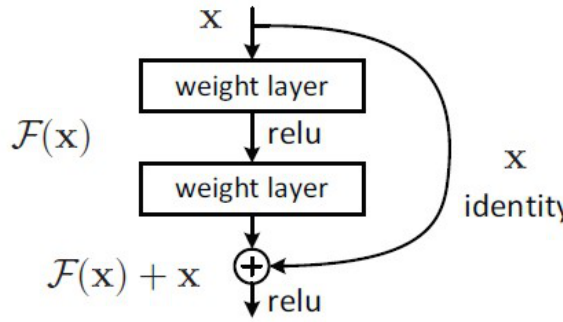
Figure 1. Schematic diagram of the ResNet-50